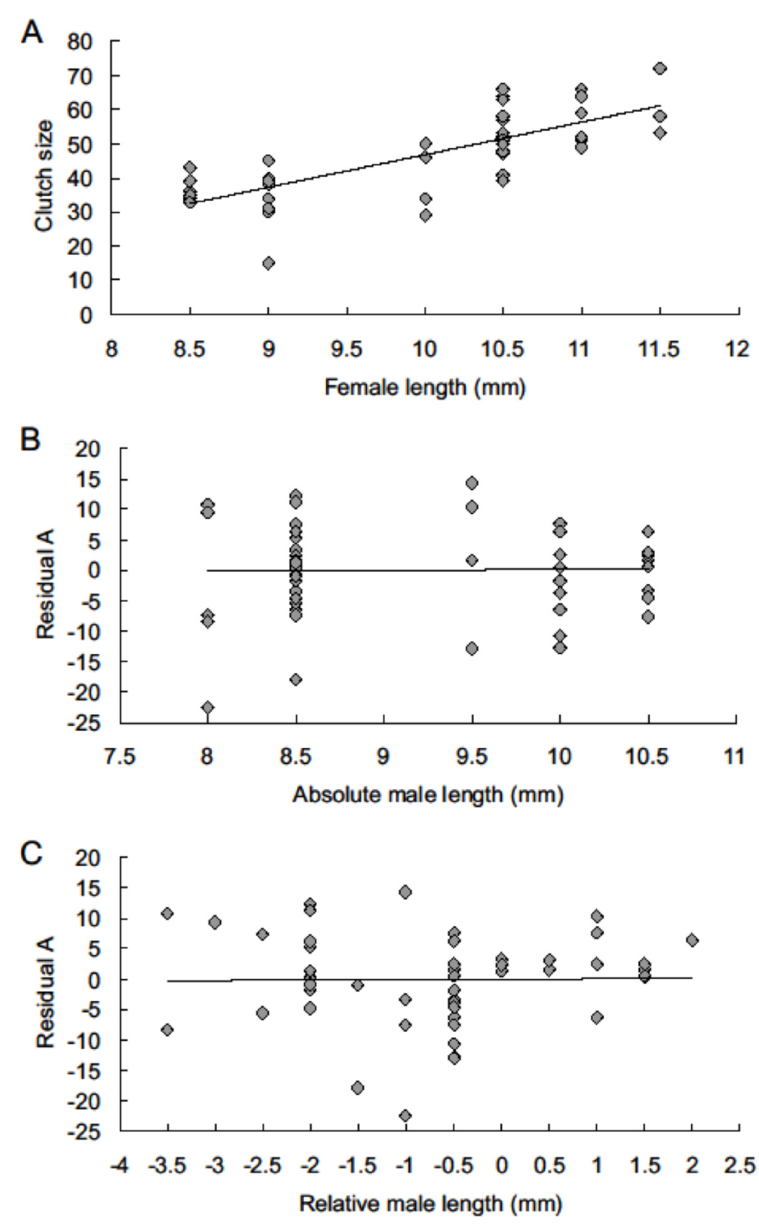
Figure 1. The relationship between fecundity and body size in the first clutch laid in 2004 experiment. ( A ): Regression of the number of eggs on female body length (y = 9.55x − 48.52, R 2 = 0.5969). ( B ): Regression of the residuals of regression A on absolute male size La (male body length, mm) (y = 0.17x − 1.59, R 2 = 0.0004). ( C ): Regression of the residuals of regression A on relative male size Lr (Lr = male body length – female body length) (y = 0.08x + 0.06, R 2 = 0.0002).